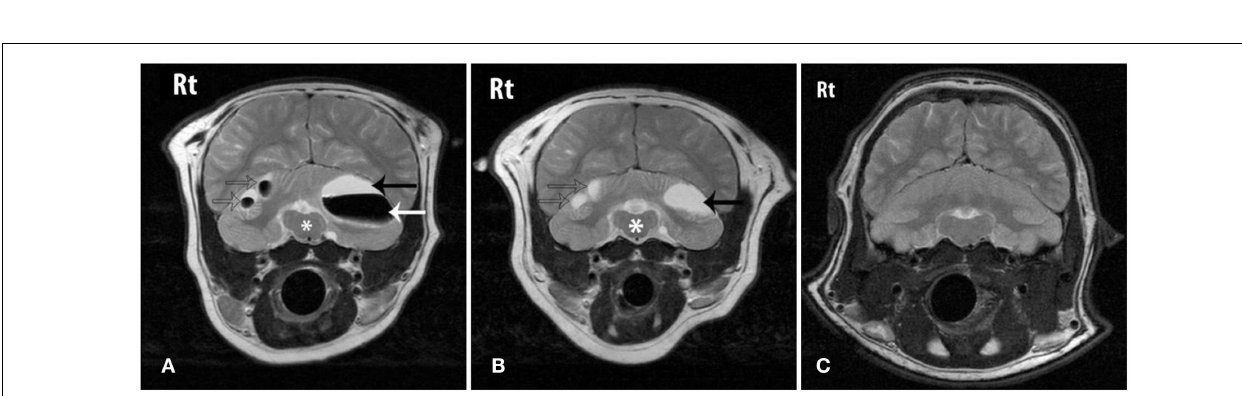
FIGURE 2 |TransverseT2W images through the caudal fossa of the patient on initial MRI (A), follow-up MRI (B) and a grossly normal cerebellum from another sea lion for comparison (C). “Rt” represents the animal’s right-side. (A) Three cerebellar lesions are shown (arrows) that contain fluid that is CSF-like in character (black arrow) and gas (white arrow).